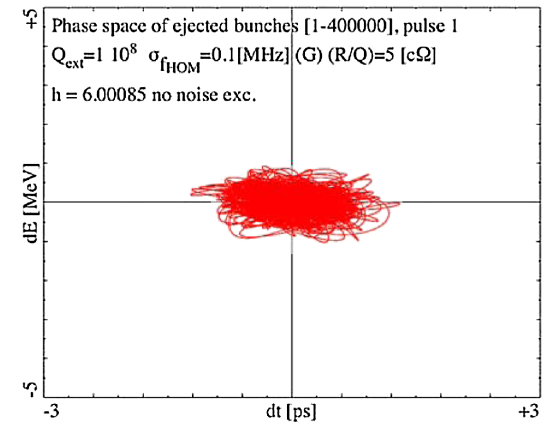
FIG. 41. (Color) Phase-space image of the ejected bunches of the second pulse. Conditions as Fig. 38 ( Q ext ¼ 10 8 ) but h f H i 0.3 MHz away from a machine line.